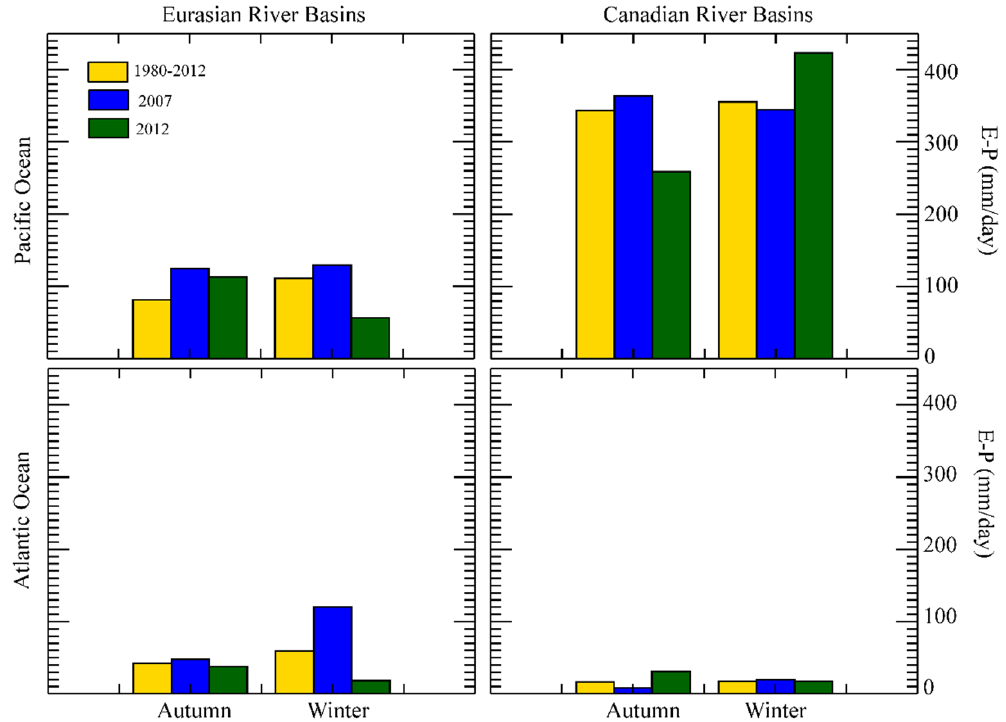
Figure 11. Mean moisture contribution over Eurasian (left-hand column) and Canadian (right-hand column) river basins from Pacific Ocean (first row) and Atlantic Ocean (second row) for 1980–2012 (yellow bar), 2007 (blue bar) and 2012 (green bar).